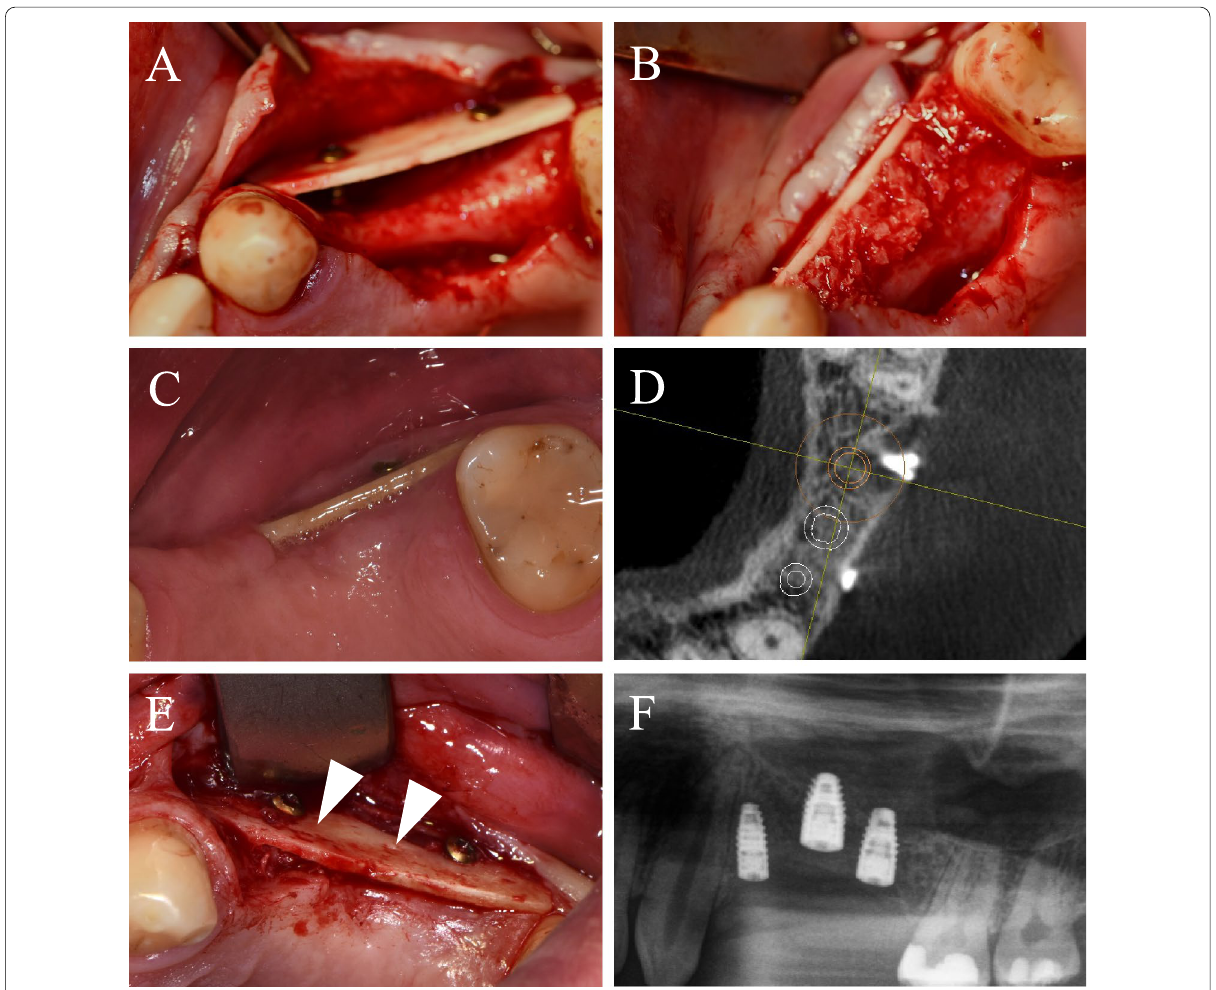
Fig. 6 Alveolar ridge augmentation of the maxilla with wound dehiscence. A The intraoperative baseline showed an extended horizontal alveolar ridge atrophy. An allogeneic cortical bone plate was fixed laterally to the defect by two adjusting screws. B The space between the allogeneic cortical bone plate and the local alveolar ridge bone was filled with spongious allogeneic granules and the area was covered by a porcine pericardial matrix. C After a few weeks, a dehiscence defect with an exposure of the allogeneic CP was found. D Surgical re-evaluation demonstrated a plate fracture along the screw holes (white arrows). E CBCT scan demonstrated a sufficient bone volume for implant placement. F X-ray demonstrating the inserted